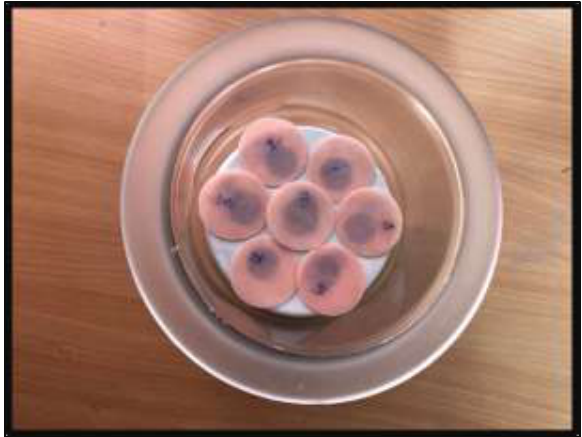
Figure 2: Specimens of water sorption and solubility were dehydrated in a dissector comprising newly dried silica gel.